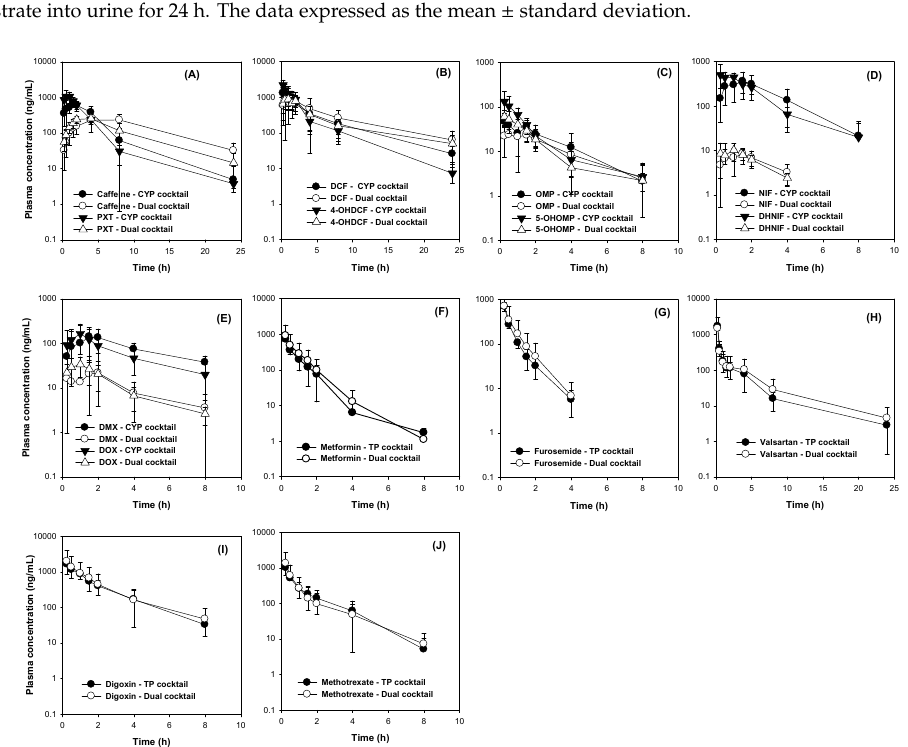
Figure 5. The plasma concentrations of ( A ) caffeine and paraxanthine (PXT), ( B ) diclofenac (DCF) and 4-hydroxy diclofenac (4-OHDCF), ( C ) omeprazole (OMP) and 5-hydroxyomeprazole (5-OHOMP), ( D ) nifedipine (NIF) and dehydronifedipine (DHNIF), and ( E ) dextromethorphan (DMX) and dextrorphan (DOX) following the administration of five CYP cocktail (closed symbol) and dual cocktail (open symbol) in rats ( n = 6). The plasma concentrations of ( F ) metformin, ( G ) furosemide, ( H ) valsartan, ( I ) digoxin, and ( J ) methotrexate following the administration of transporter (TP) cocktail (closed symbol) and dual cocktail (open symbol) in rats ( n = 6). The CYP cocktail consists of caffeine (1 mg/kg), diclofenac (2 mg/kg), omeprazole (2 mg/kg), nifedipine (0.5 mg/kg), and dextromethorphan (10 mg/kg) and orally administered. The TP cocktail consists of metformin (0.5 mg/kg), furosemide (0.1 mg/kg), valsartan (0.2 mg/kg), digoxin (2 mg/kg), and methotrexate (0.5 mg/kg) and administered via intravenous injection. Dual cocktail is a mixture of CYP and TP cocktails. The data are presented as the means ± SD ( n = 6 for CYP cocktail or transporter cocktail, n = 7 for dual cocktail).